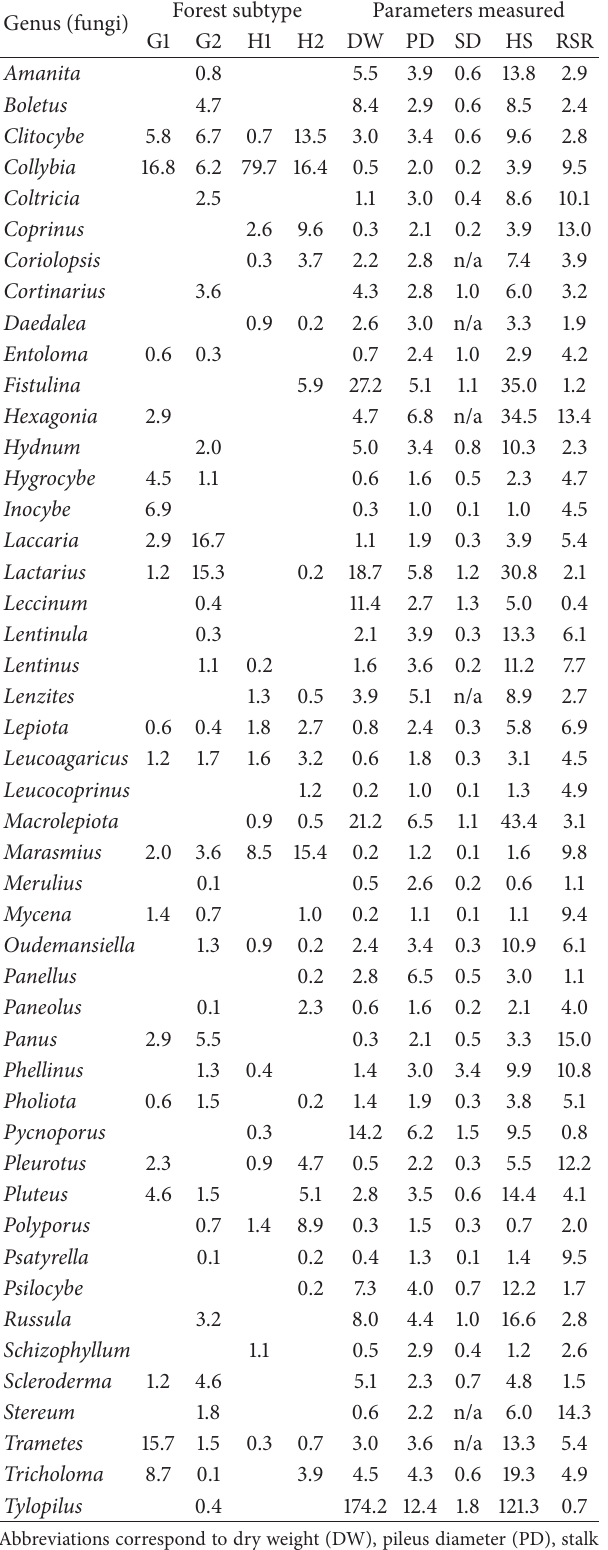
Table 3: Relative percentages of fruiting body incidence by forest subtype and average values for parameters measured across some of the fungal genera observed in the present study.